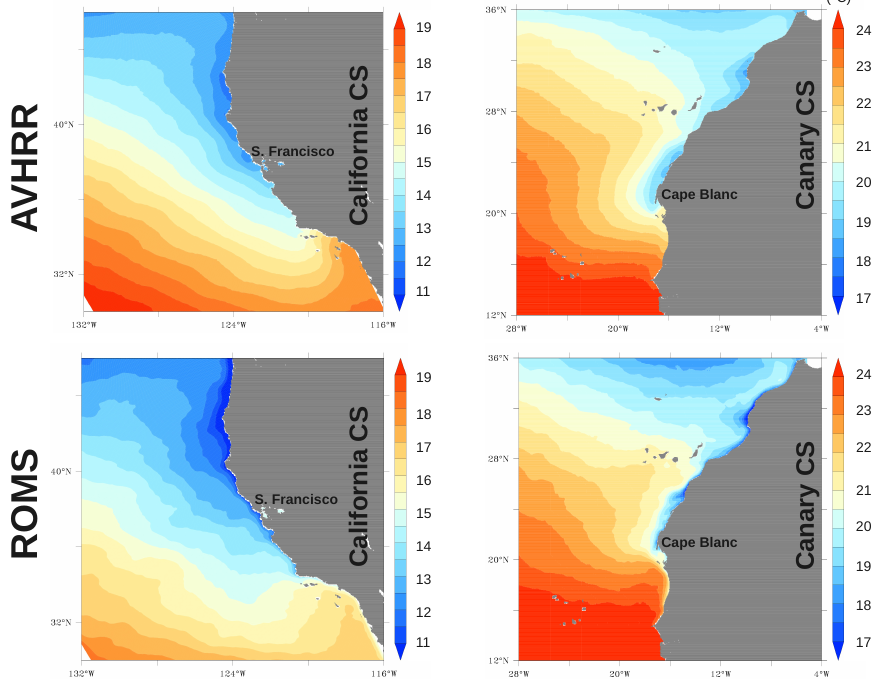
Fig. 2. Sea surface temperature (SST) annual average ( ◦ C) from AVHRR (top) and ROMS model (bottom) in the California CS (left) and the Canary CS (right). The AVHRR observational climatology is computed over the period from 1997 to